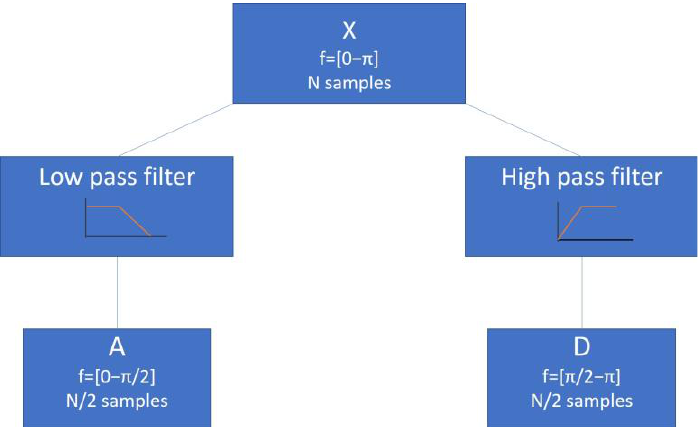
Figure 3. DWT procedure.